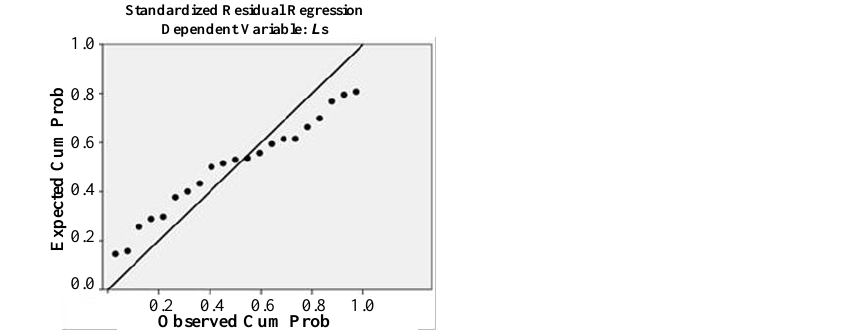
Table 6. Percentage error of L s .